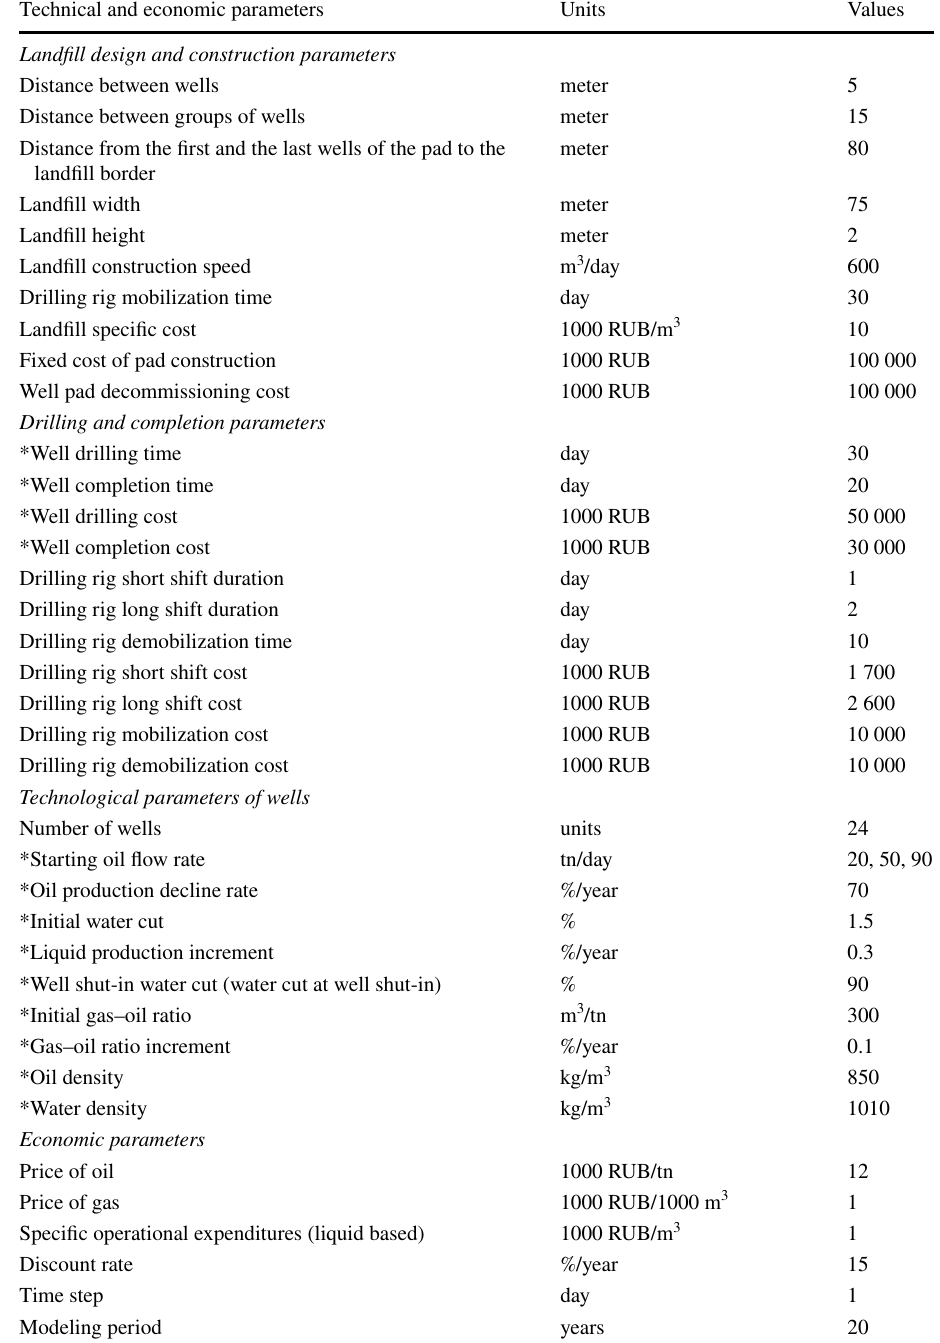
Table 1 Parameters of the simulation